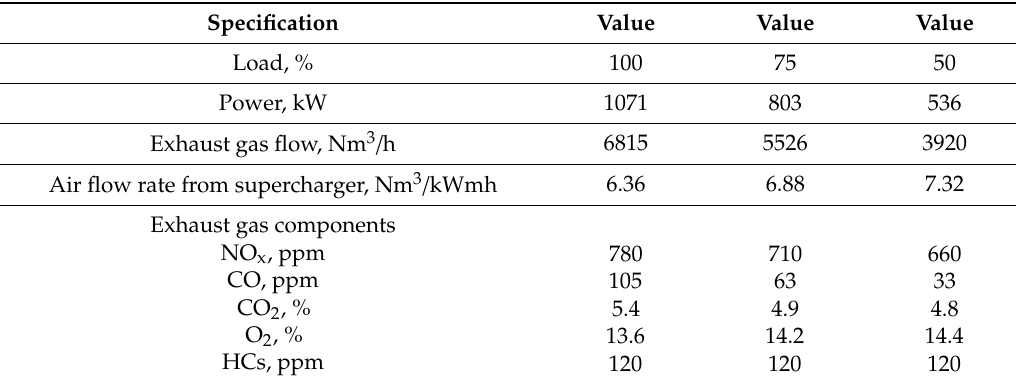
Table 2. Operating conditions of the marine diesel engine